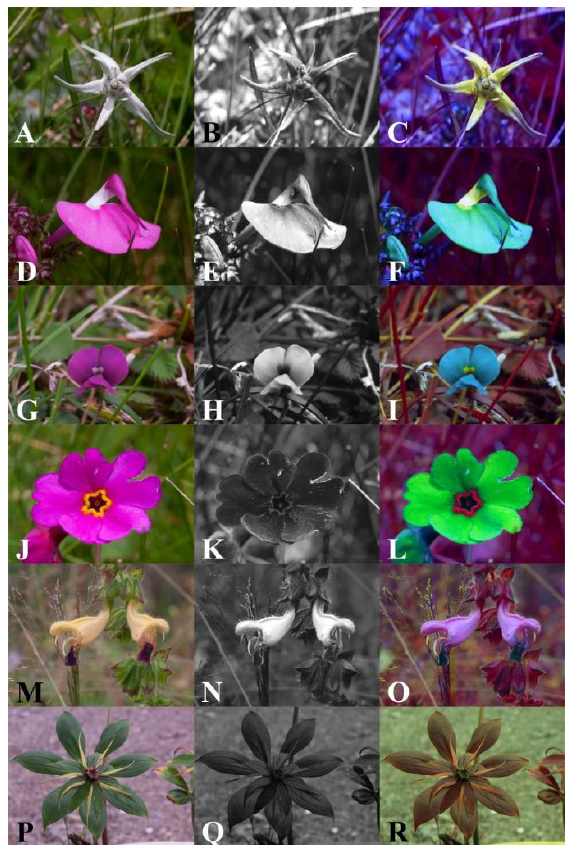
F IGURE 20. Colour pictures (left), UV-pictures (middle) and false-colour pictures (right) of flowers taken under field conditions in Lijiang (Yunnan, China). Leontopodium sp. (A, B, C), Pedicularis cephalantha Franch. ex Maxim. (D, E, F), Tibetia yunnanensis (Franch.) Tsui (G, H, I), Primula poissonii Franch. (J, K, L), Salvia hylocharis Diels (M, N, O), Paris polyphylla var. yunnanensis (Franch.) Hand.-Mazz (P, Q,